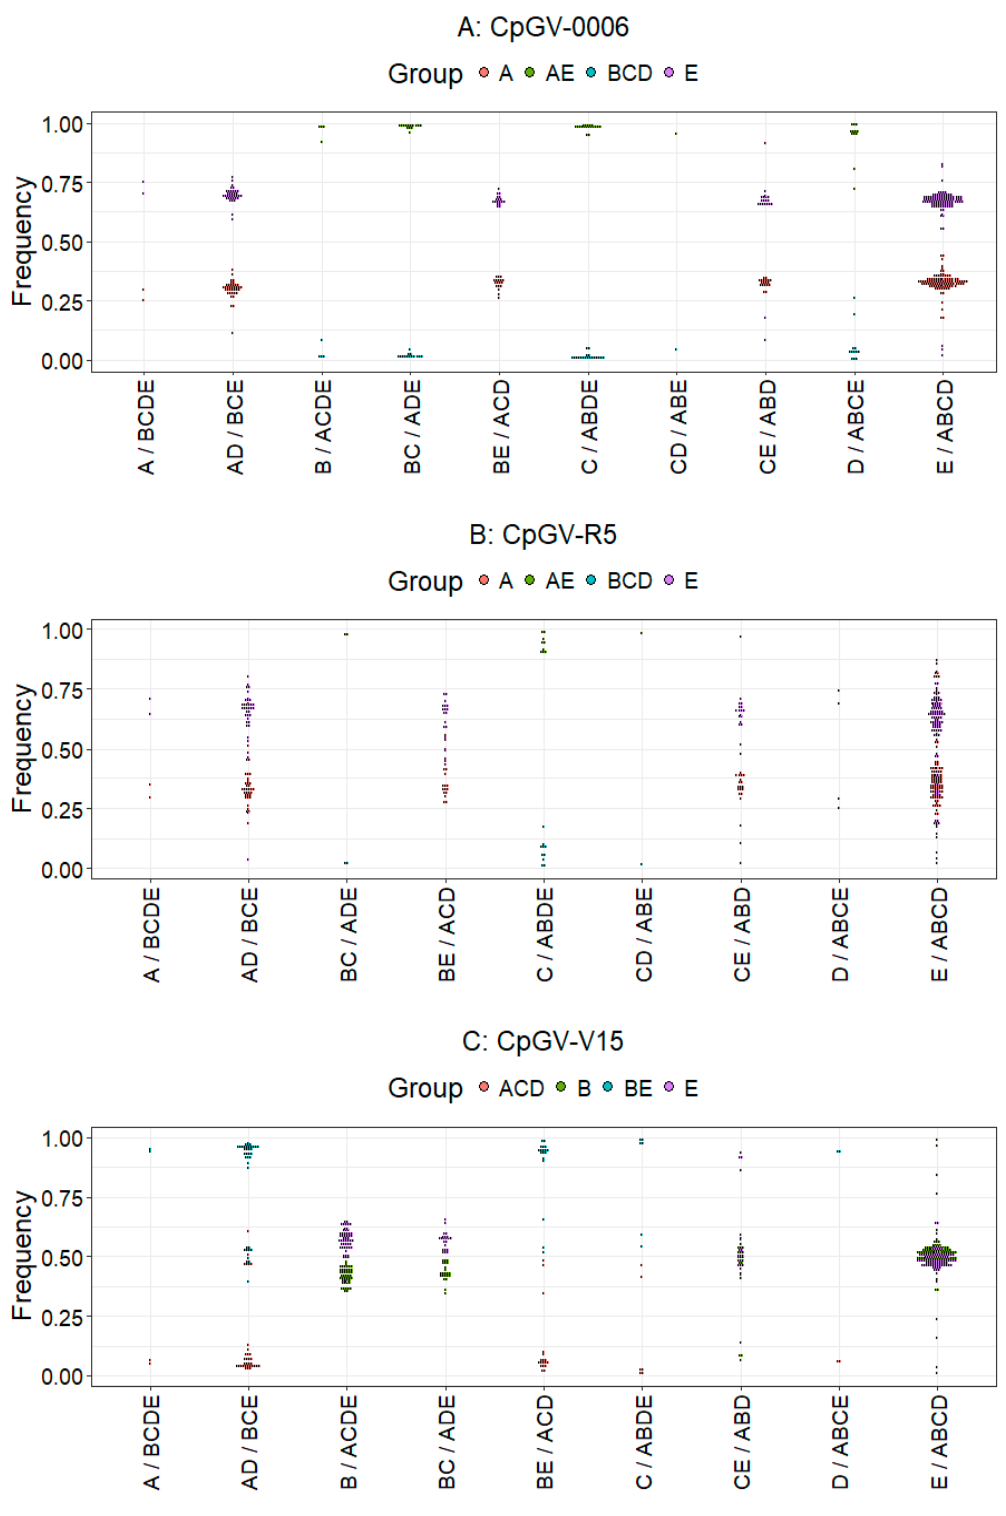
Figure 6. Geometric dot-plot charts of SNPs found in the Bowtie2 mappings of CpGV-0006 ( A ); CpGV-R5 ( B ); and CpGV-V15 ( C ). Given are the frequencies of nucleotide reads at positions assigned to the genome groups A, B, C, D, and E, as well as combinations of these. Data points are grouped together by genome groups A, E, and BCD for CpGV-0006 and CpGV-R5, as well as by genome B, E, and ACD for CpGV-V15, respectively.